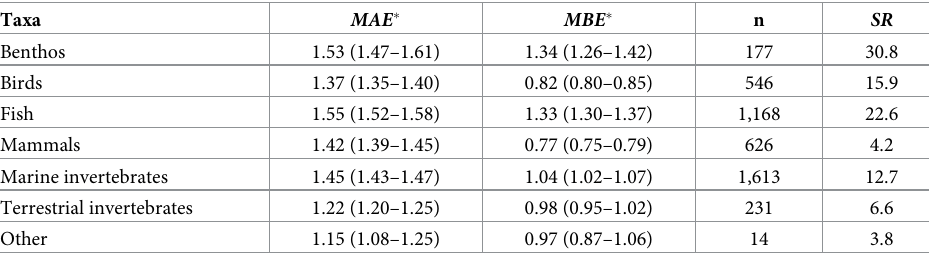
Table 1. Per-taxa breakdown of community data and bias assessment metrics.